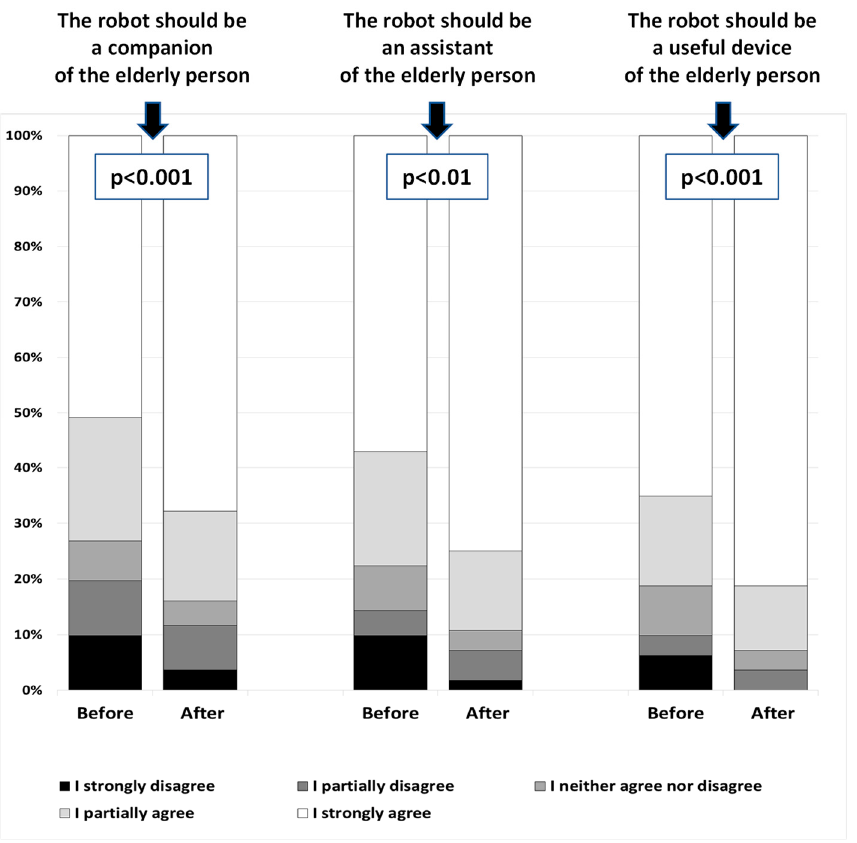
Figure 2. The robot’s roles: scores before and after interaction with the robot. Table 1. UNRAQ results before and after interaction with the robot.